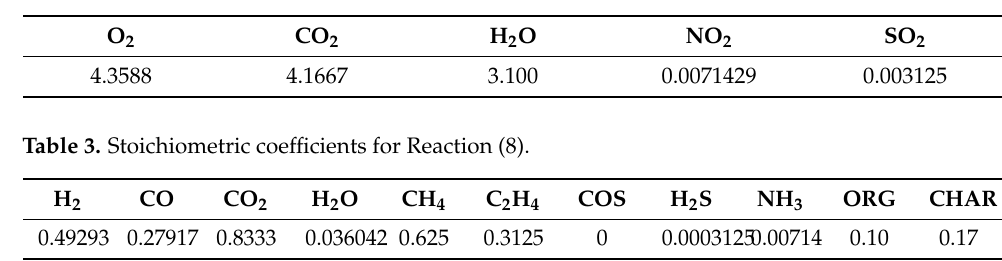
Table 2. Stoichiometric coefficients for Reaction (7).